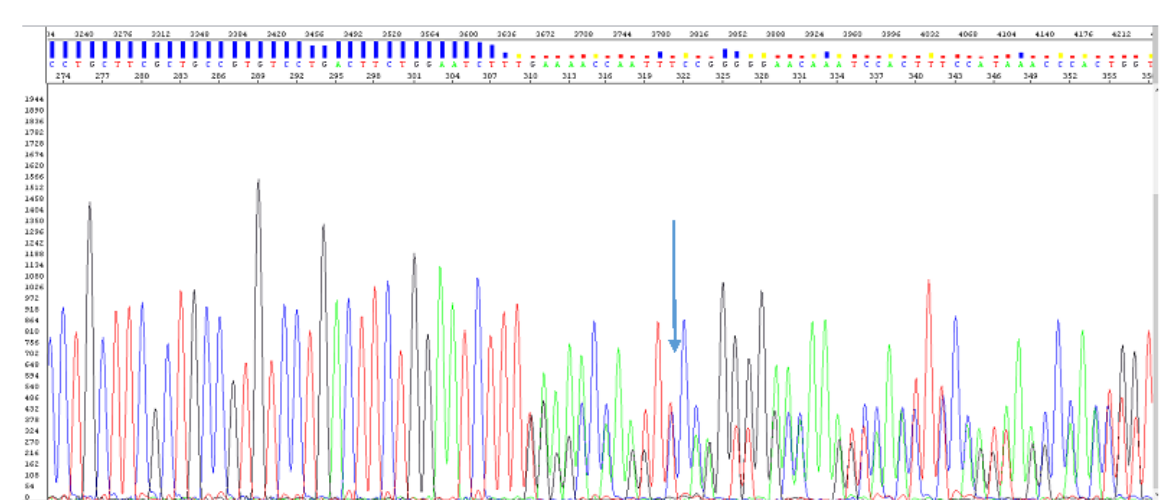
Figure 4. Sanger sequencing of the GNAS exon 8, showing (blue arrow) the heterozygous variant NM_000516.4: c.624dup (p.Glu209*).